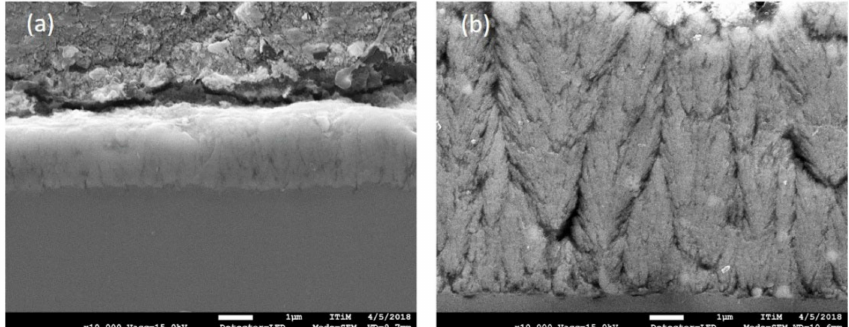
Figure 1. Characteristic columnar structure observed by high-resolution SEM. Scale bar = 1 µ m; ( a ) Ti_10_100; ( b ) Ti_10_400.